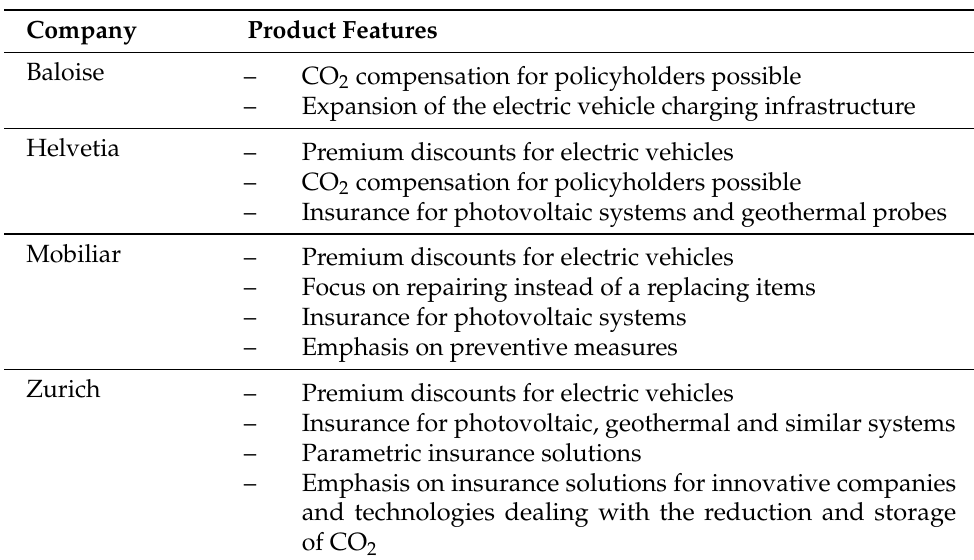
Table 1. Examples of product features published by Swiss insurers in annual reports as of 2021 (adapted from Fey